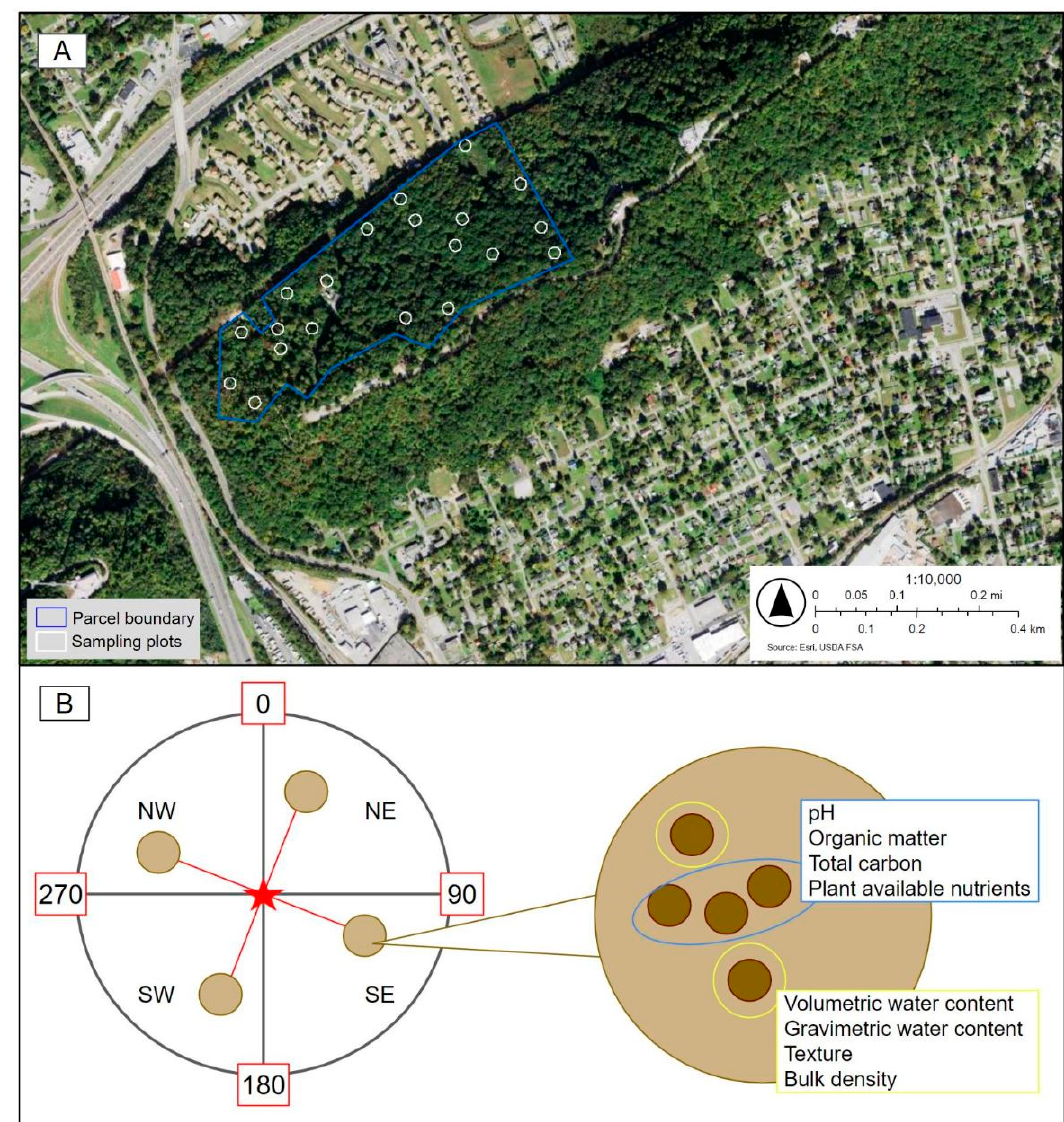
Figure 1. ( A ) Locations of the 17 ecological sampling plots across the 17-hectare parcel located on Sharp’s Ridge, Knoxville, Tennessee. ( B ) Ecological assessment plot diagram for attribute collection at each field site. Image modified from Natural Areas Conservancy Protocol (unpublished document). Ecological attributes collected at each sampling plot are as follows (modified from [38]): Overstory trees (>10 cm DBH). For each 11.3 m radius plot: species identification, diameter at breast height, vigor, and vine cover growth stages. Midstory trees (2–10 cm DBH). For each 11.3 m radius plot: Species identification and vine cover growth stages. Understory: species identification and per- cent cover in 4 1 m × 1 m subplots. Human impacts were measured as proportion of each plot show- ing human disturbance (e.g., litter, trampling). Ecological impacts were measured as proportion of each plot showing canopy gaps and other evidence of natural disturbances. Soil attributes measured